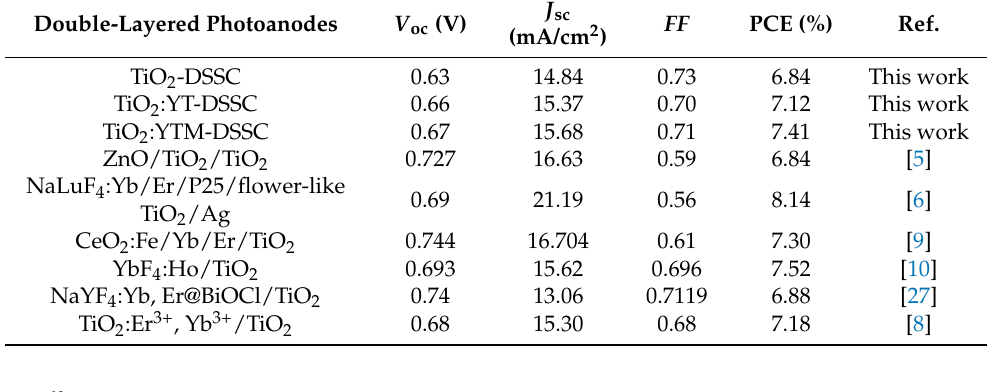
Table 1. The performances of TiO 2 -DSSC, TiO 2 :YT-DSSC and TiO 2 :YTM-DSSC, and the performances of DSSCs with double-layered photoanodes and DSSCs with UC layers.